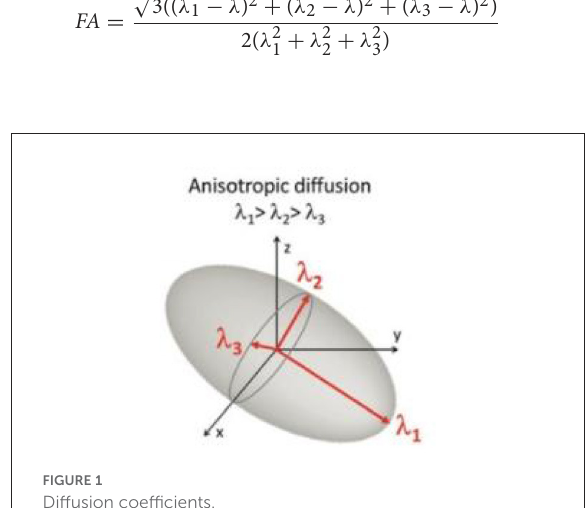
FIGURE1 Diffusion